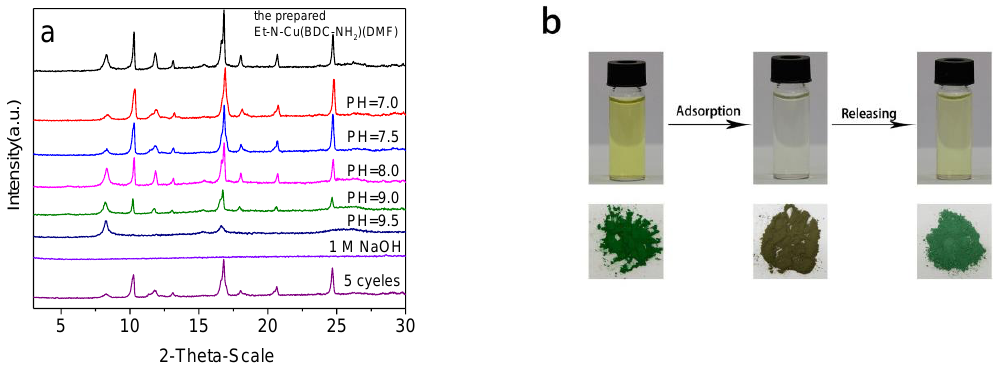
Figure 9. ( a ) The XRD patterns of Et- N -Cu(BDC-NH 2 )(DMF) (6d) at different pH values, compared with the prepared one (Room temperature). pH = 7.0 (24 h), pH = 7.5 (24 h), pH = 8.0 (24 h), pH = 9.0 (2 h), pH = 9.5 (1 h), 5 cycles (pH = 7.0), 1 mol L − 1 NaOH (1 h). ( b ) The photographs show adsorption and releasing metal cyanide complexes using Et- N -Cu(BDC-NH 2 )(DMF) adsorbent.